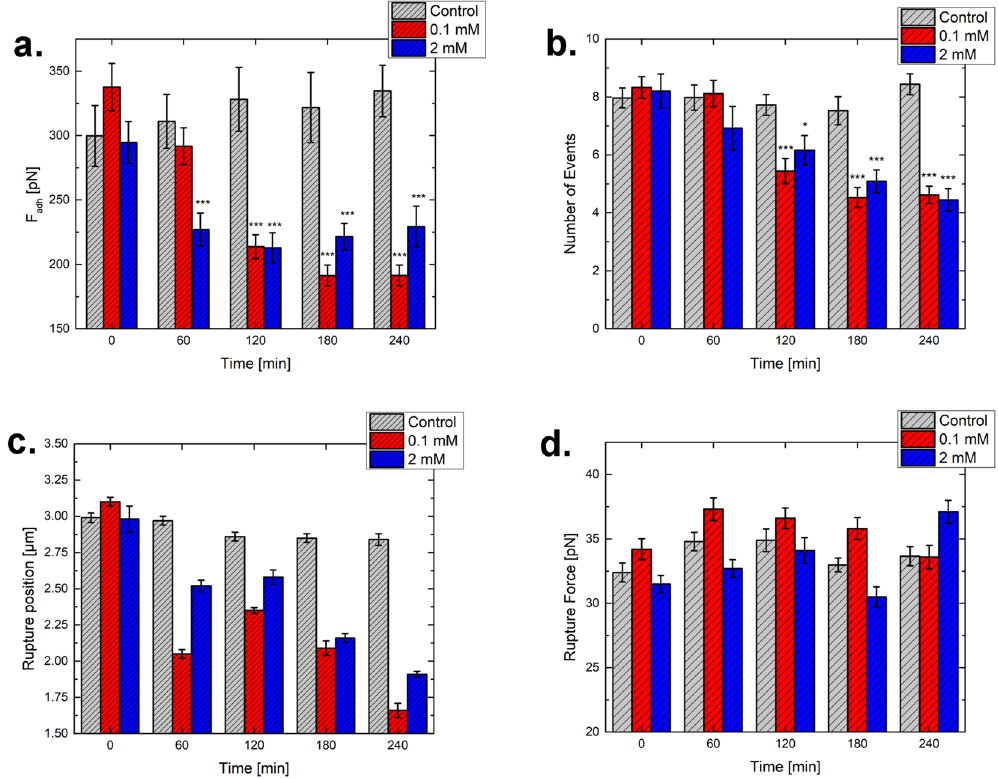
Figure 5. Adhesion between cells and tip for control (light grey), 0.1 mM (red) and 2 mM (blue) colchicine over a time of 240 minutes. ( a ) Shows the maximum cell-tip force ( b ) Number of events per measurement, ( c ) Position of rupture events, and ( d ) Force of the rupture events. For the adhesion force and the number of rupture events, the mean values with the standard error of the mean are shown. For the rupture force